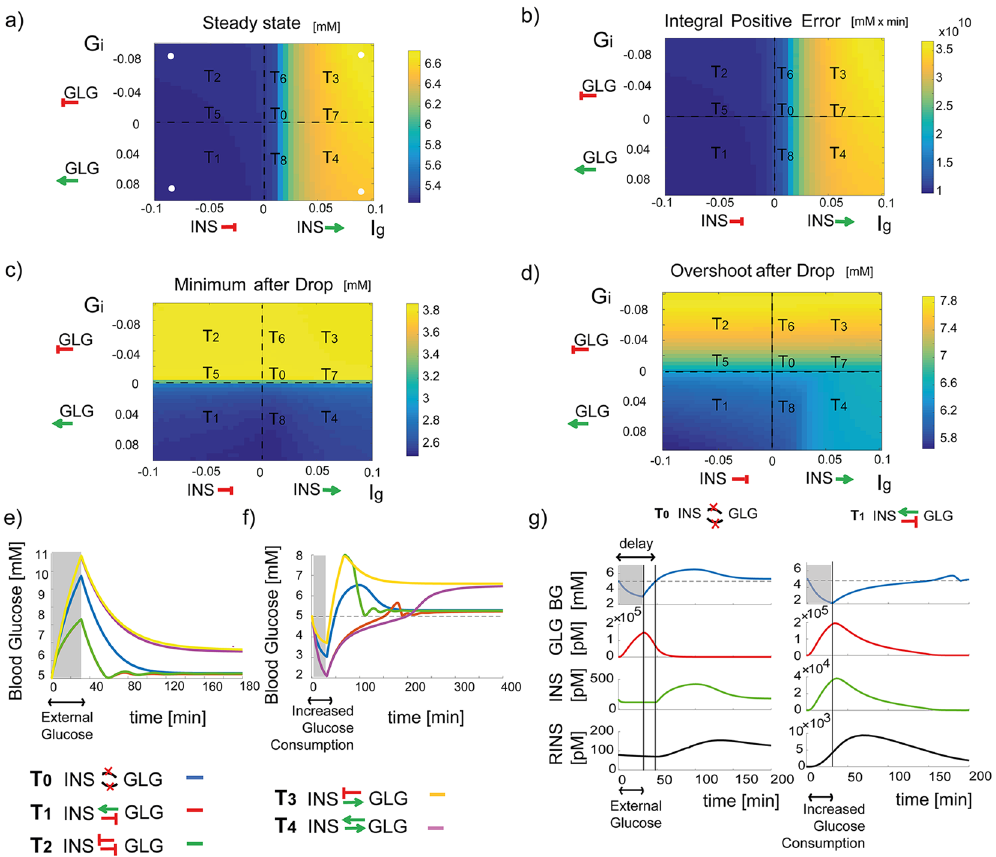
Figure 2. Local analysis reveals features of all circuit topologies. Shown are the blood glucose steady states ( a ) integral positive error ( b ) minimum level after a glucose drop ( c ) and maximum overshoot after reversion from glucose drops ( d ). For each pair of parameters ( I g , G i ) the system responses to 30 minute glucose INPUT and 30 minute glucose DROP were simulated and scored. Integral error has been evaluated on a 500-minute time interval. White dots represent each pair of parameters represented in ( e and f ); different areas are labeled with the corresponding topology. ( e-f ) Simulations of blood glucose response to a 30-minutes positive/negative pulse: external stimuli are represented by the grey shaded area and response of systems T 0 , T 1 , T 2 , T 3 , T 4 are represented respectively in blue, red, green, yellow and purple. ( g ) Comparison between topologies T 0 , T 1 , for the behavior of blood glucose ([ BG ]), glucagon ([ GLG ]), insulin ([ INS ]) and remote insulin ([ Rins ]), after an increased glucose consumption of 30 minutes (grey shaded area): in the T 0 topology insulin ramps up with a delay of 50 minutes. In all the analyses, V r = K = 10 − 5 and ω =